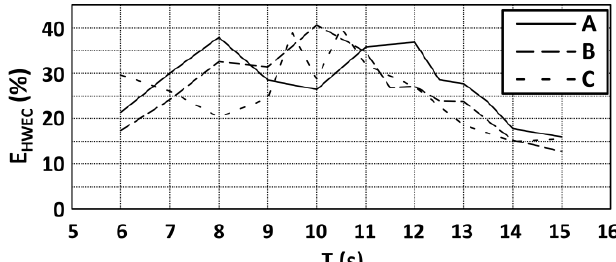
Fig. 10. Hydraulic/hydrodynamic efficiency of the h-WEC as a function of the wave period.